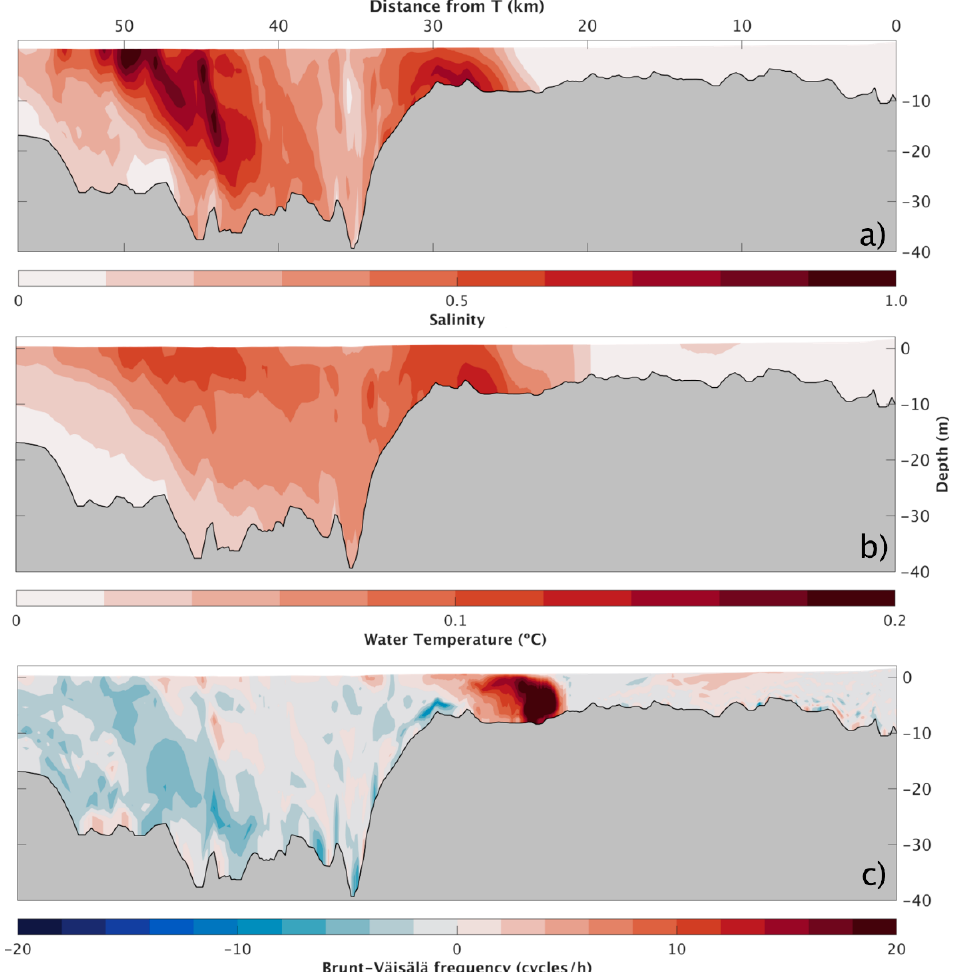
Figure 8. Difference between #Sc2 and #ScRef, in terms of ( a ) salinity; ( b ) water temperature; ( c ) Brunt–Väisälä frequency. ( c ) Brunt–Väisälä